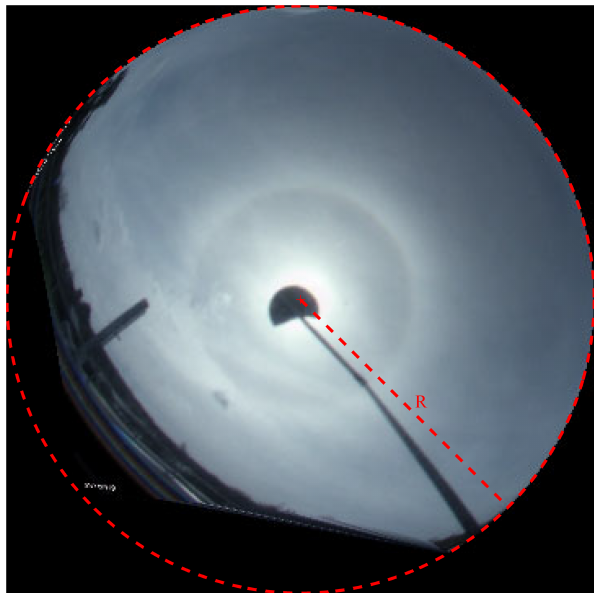
Figure 5. Image from Fig. 4 after rotation (upper hemisphere only). R is the radius of the sphere onto which the original images are mapped.